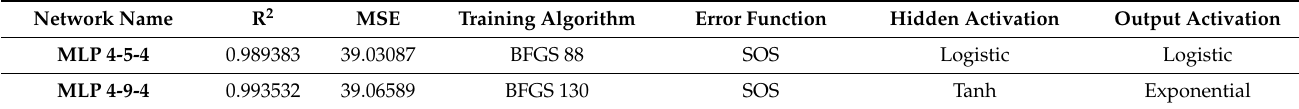
Table 3. Summary of MLP-4-5-4 and MLP-4-9-4 active networks.